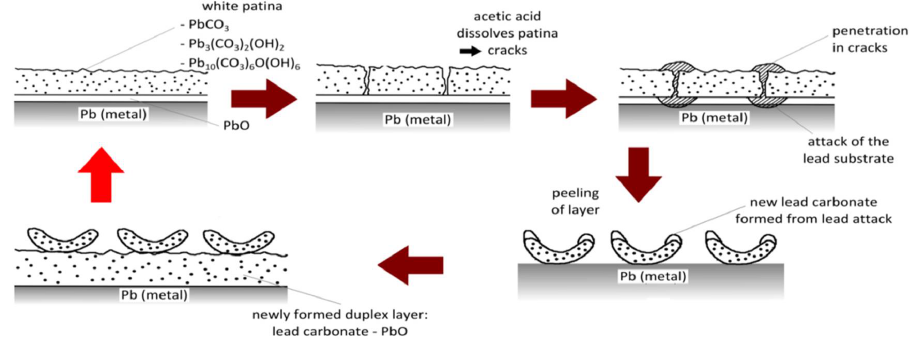
Figure 1. Schematic mechanism of lead corrosion by acetic acid. Reproduced from [13] with permission; Copyright Elsevier